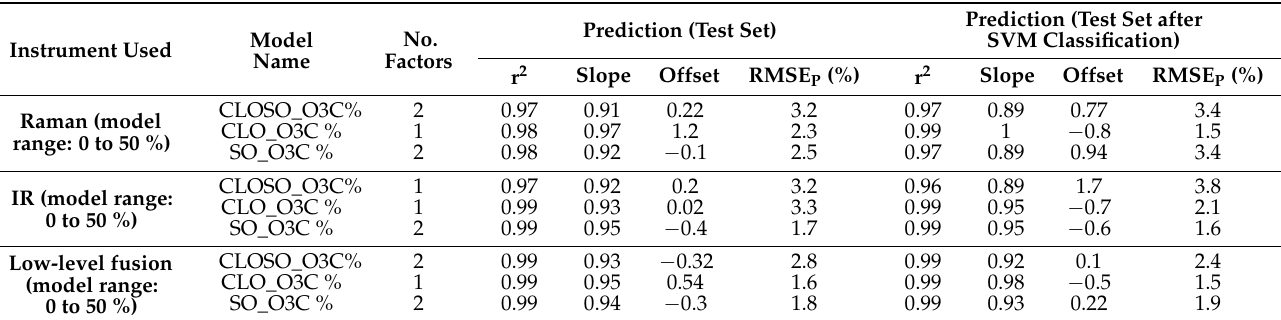
Table 3. Test set performance for PLSR-based quantitative assessment of O3C adulteration in CLO and SO.